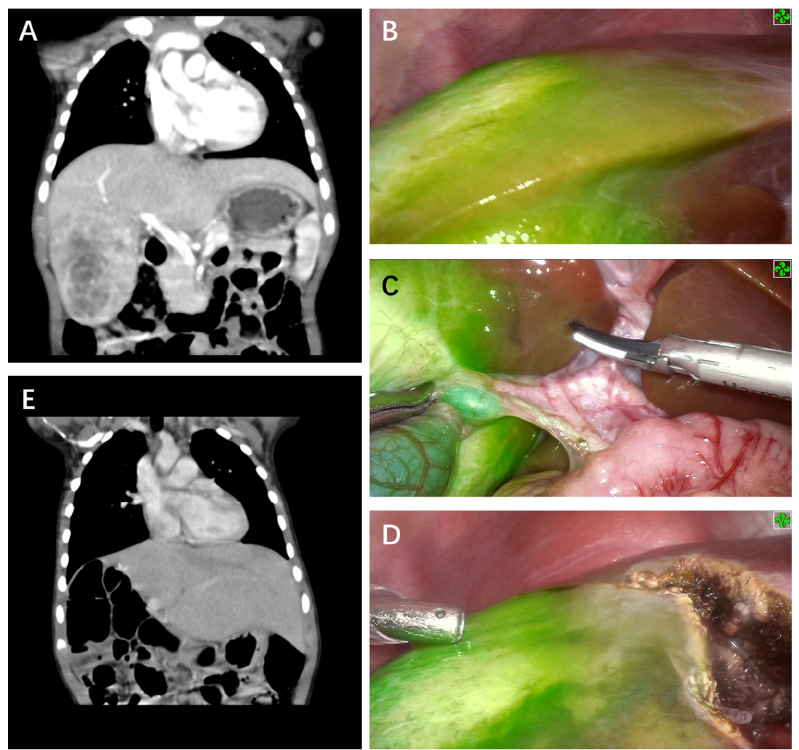
Figure 2. ICG fluorescence-guided laparoscopic right hepatectomy. ( A ) Preoperative CT image of coronal position and cross-section. ( B ) Tumor fluorescence was obvious during surgery with clear demarcation of normal tissue. ( C ) The relationship between tumor and biliary tract, hepatic artery, and portal vein were identified in fluorescence mode. ( D ) The marking line was continuously corrected according to fluorescence imaging during tumor resection. ( E ) No signs of tumor residues or recurrence were observed via CT 12 months after surgery.